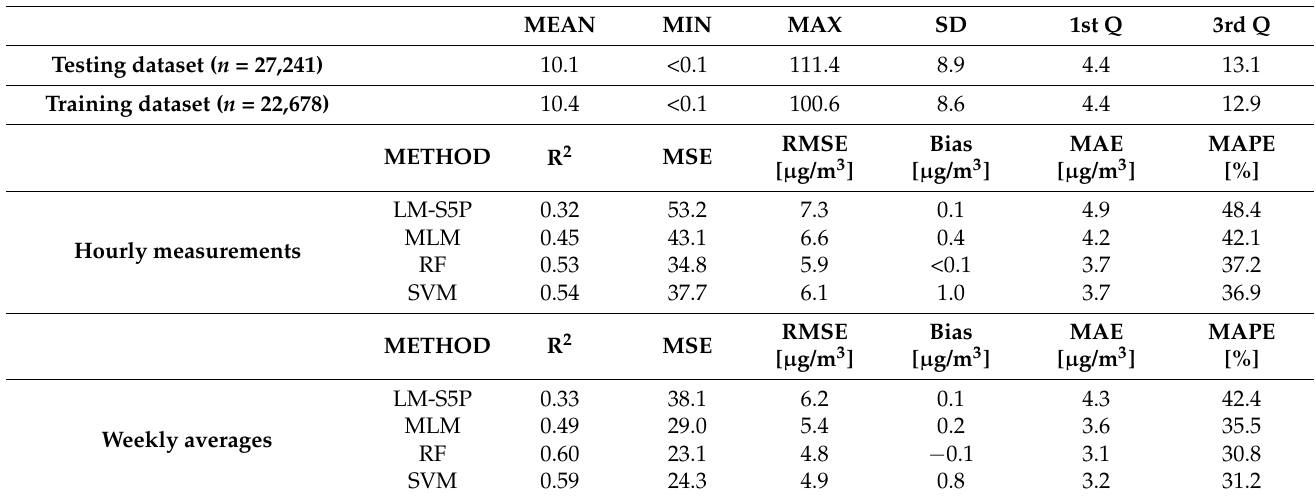
Table 1. Statistics of prediction of NO 2 surface mass concentration with use of various tech- niques: LM-S5P—Linear regression with one independent variable (NO 2 derived by Sentinel-5P); MLM—Multiple linear regression with several independent variables; RF—Random forest; SVM—Support Vector